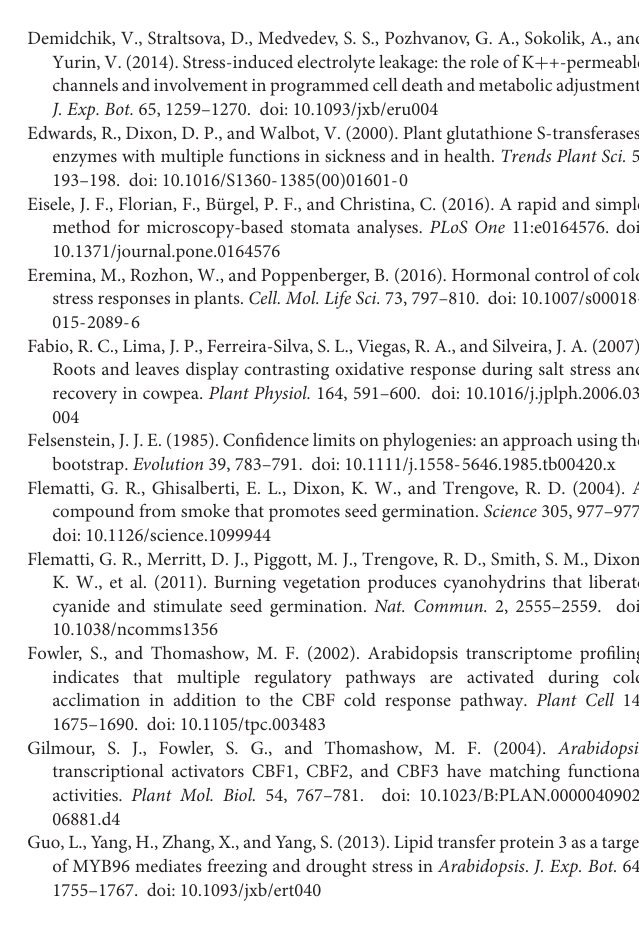
Supplementary Figure 1 | Bioinformatics analysis of KAI2 . Supplementary Figure 2 | Exogenous application of KAR 1 alleviated cold tolerance in Arabidopsis. Supplementary Table 1 | List of